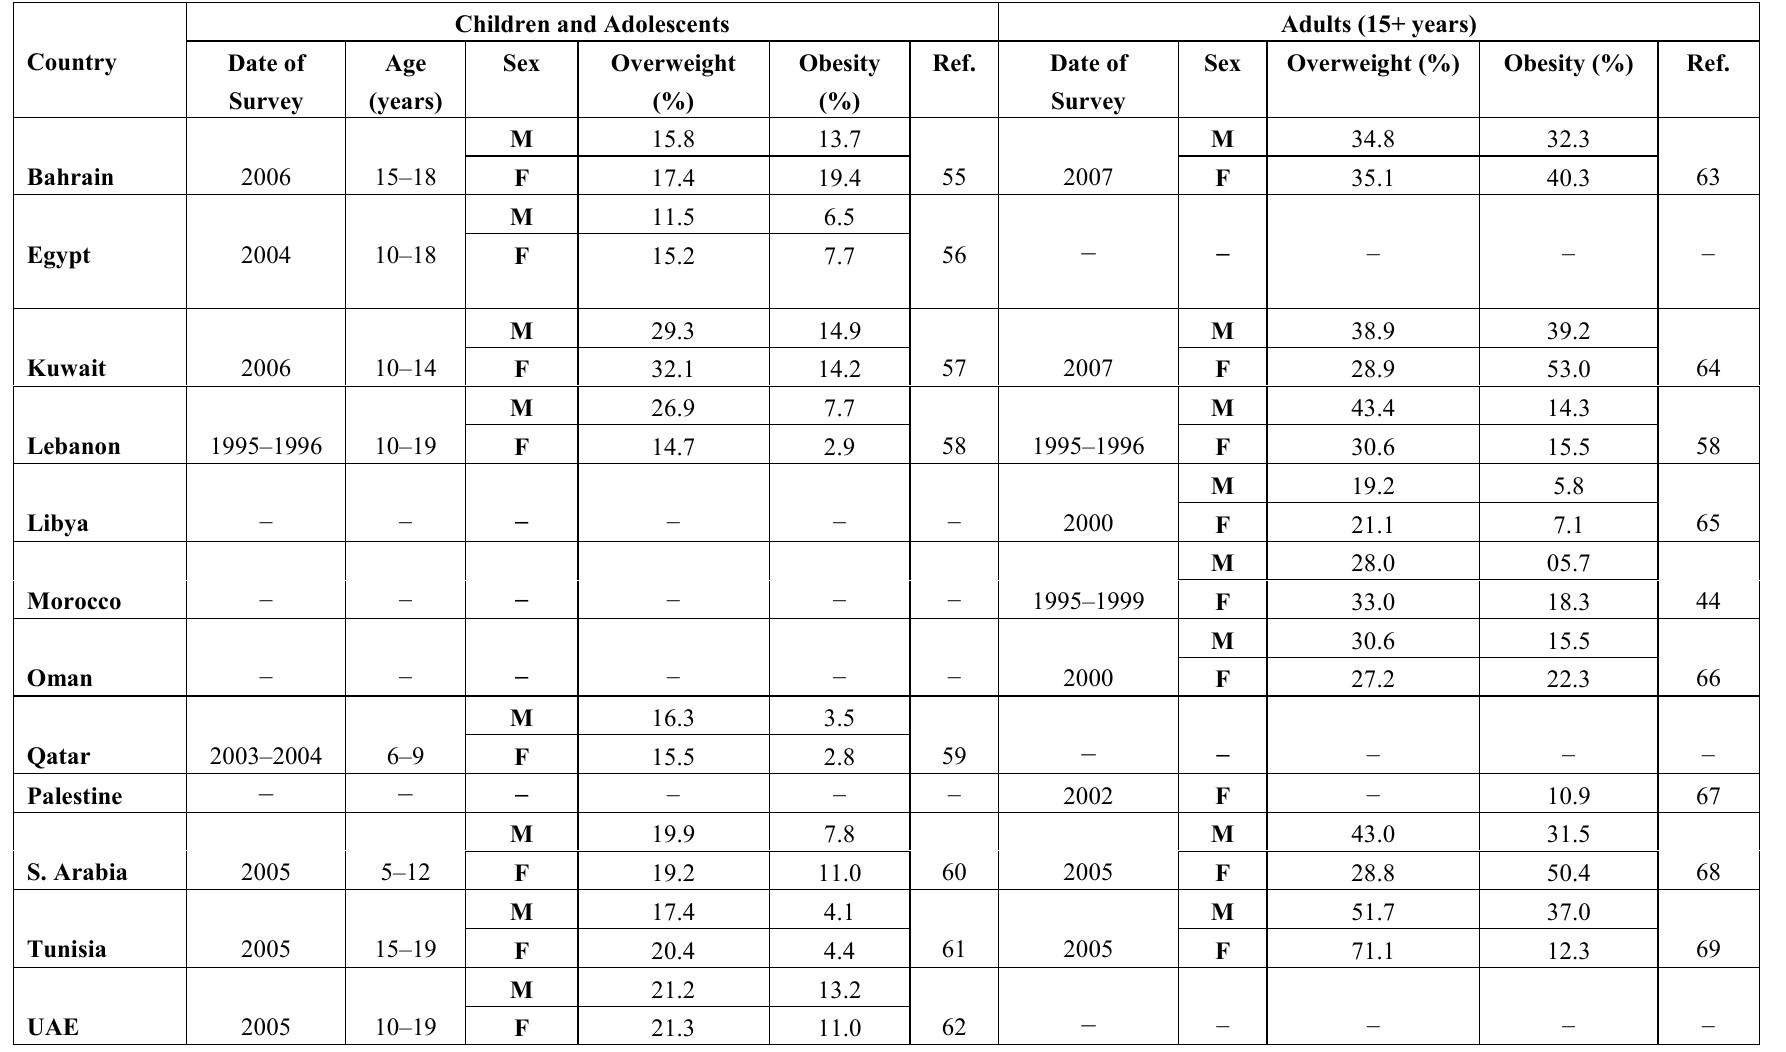
Table 3. National prevalence of overweight and obesity among children, adolescents and adults in selected Arab countries.